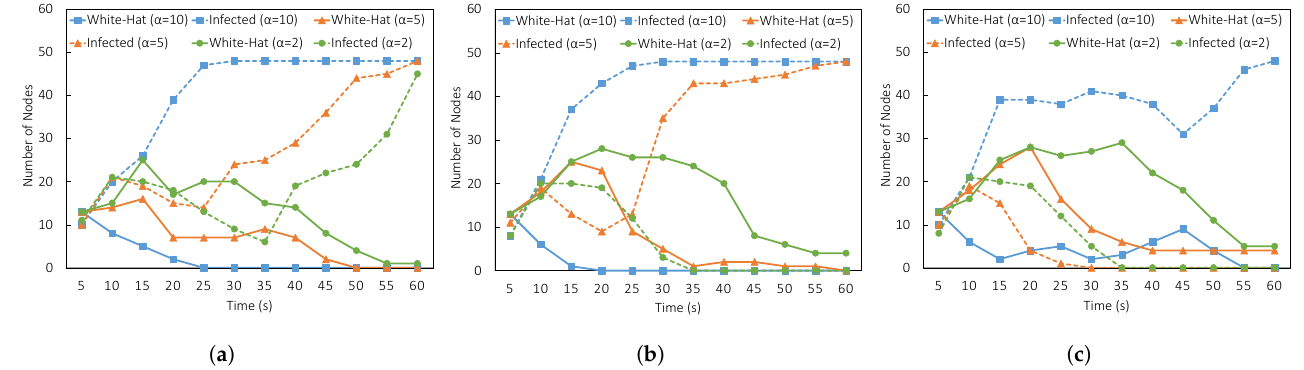
Figure 7. Comparison of result based on initial lifespan L . ( a ) Experiment result ( L = 5, α = { 10,5 } ). ( b ) Experiment result ( L = 10, α = { 10,5 } ). ( c ) Experiment result ( L = 20, α = { 10,5 }